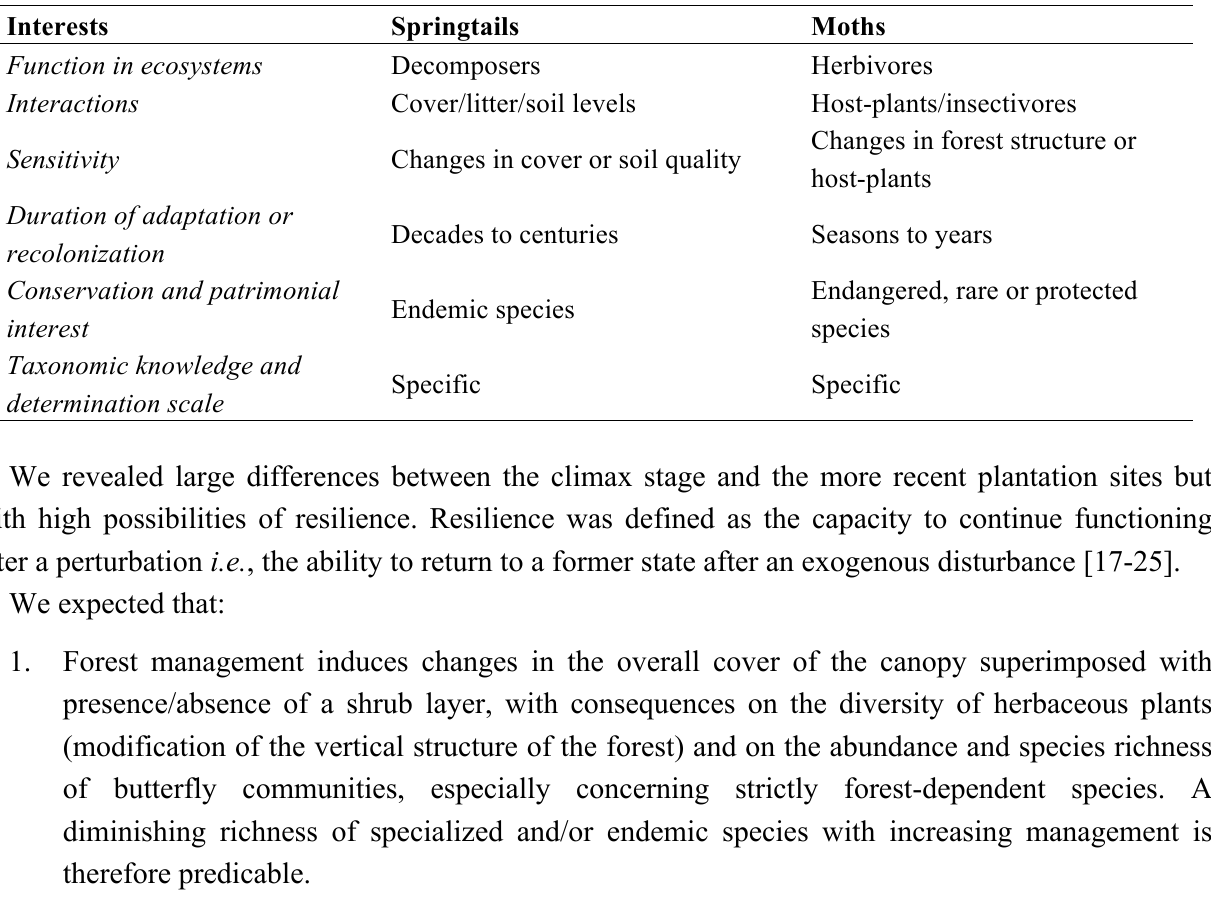
Table 1. Different and complementary interests of the marker groups